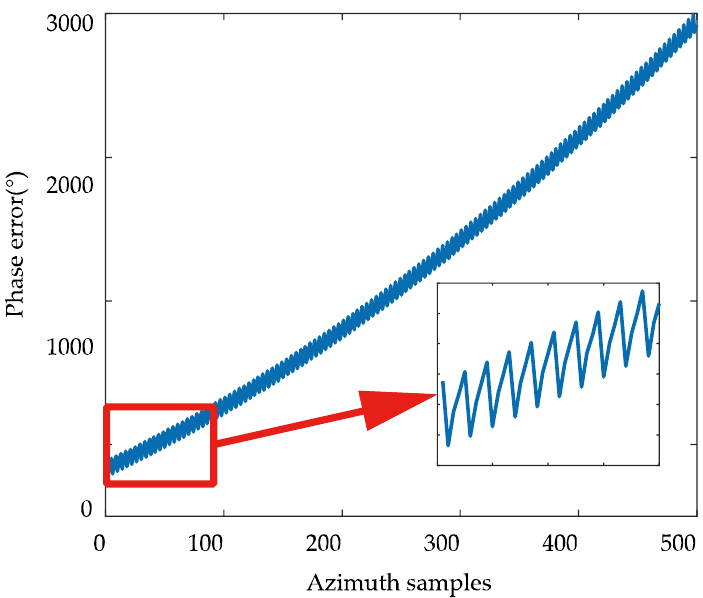
Figure 5. Phase error sequence after rearrangement and local enlargement.